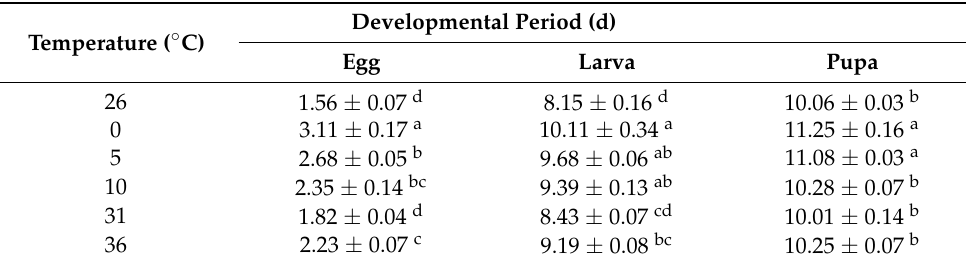
Table 1. Developmental periods of different stages of B. dorsalis subjected to various short-term high- and low-temperature